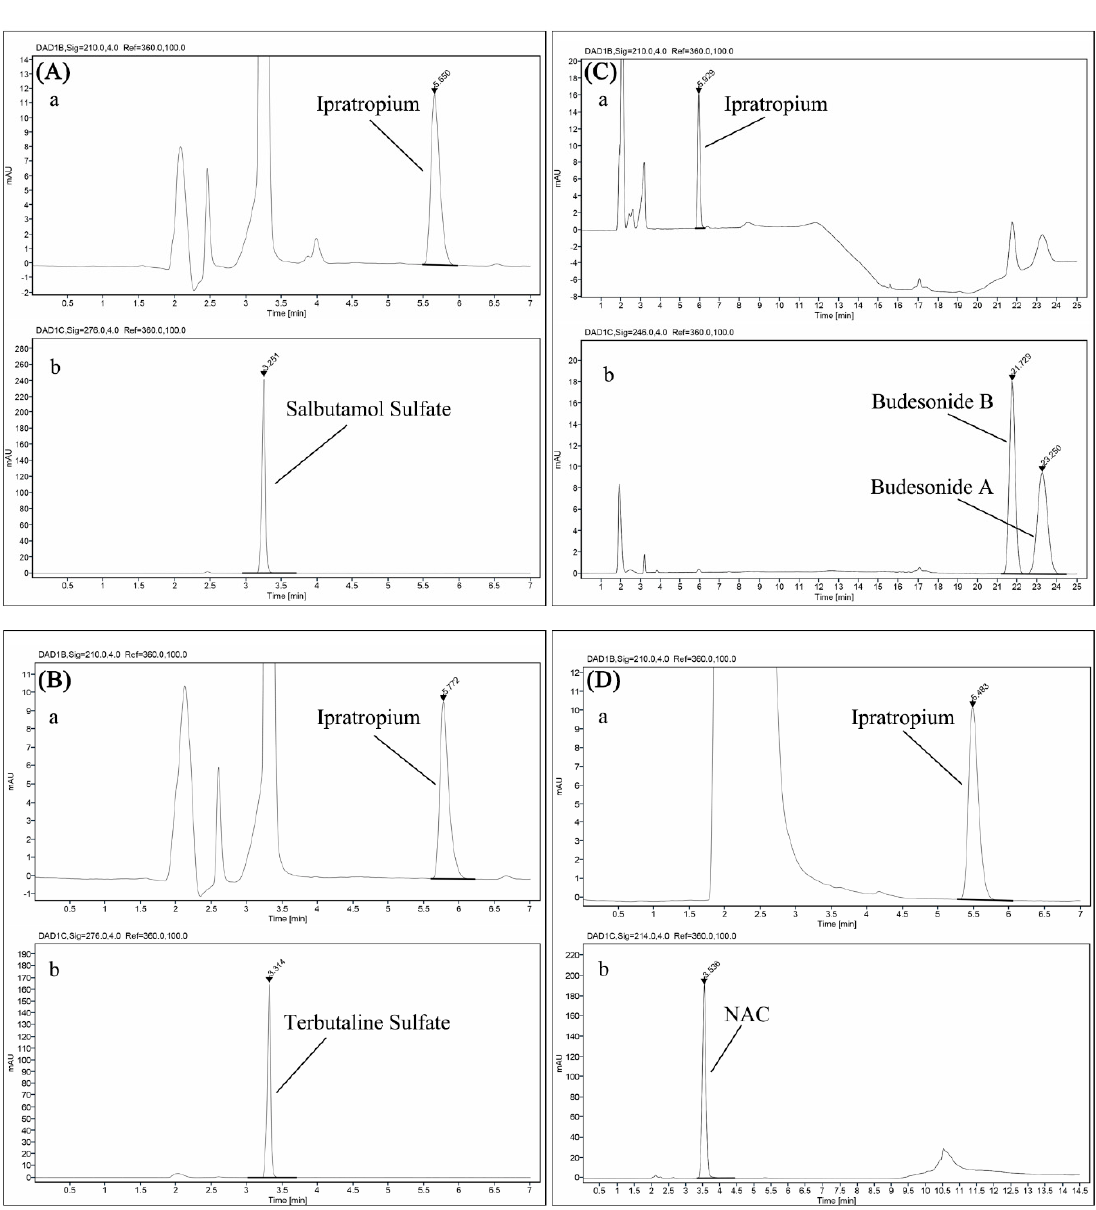
Figure 4. HPLC chromatograms of ( A ) Atrovent ® / Ventolin ® (( a ) 210 nm for ipratropium bromide, ( b ) 276 nm for salbutamol sulfate)), ( B ) Atrovent ® / Bricanyl ® (( a ) 210 nm for ipratropium bromide, ( b ) 276 nm for terbutaline sulfate)), ( C ) Atrovent ® / Pulmicort ® (( a ) 210 nm for ipratropium bromide, ( b ) 246 nm for budesonide)), and ( D ) Atrovent ® / Fluimucil ® (( a ) 210 nm for ipratropium bromide, ( b ) 214 nm for NAC)).